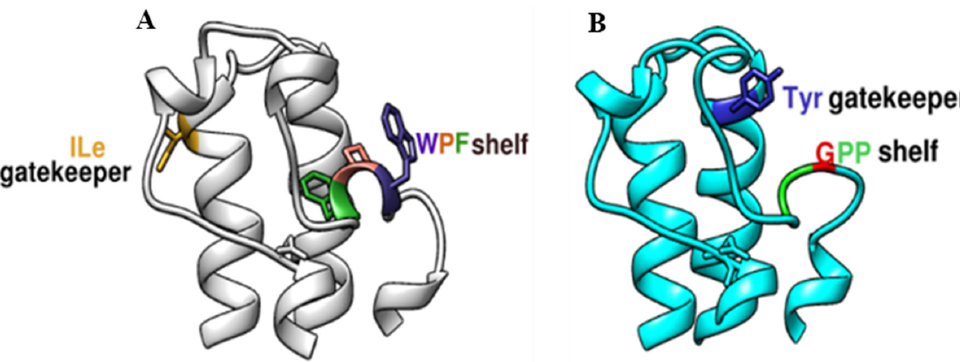
Figure 2. Structural Difference between the binding pocket were retained by Chimera [17], ( A ) BRD4 and ( B ) BRD9, GPP shelf and Tyr106 (gatekeeper) in BRD9 is replaced by WPF shelf and Ile (gatekeeper residue) in BRD4.